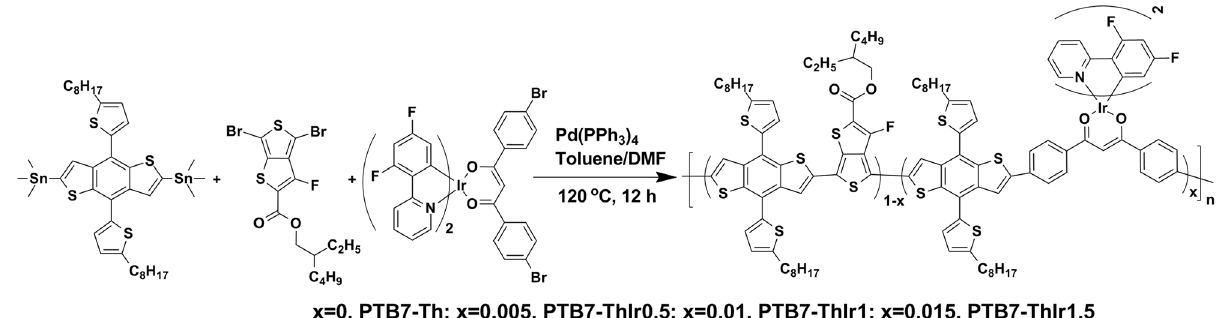
Fig. 1 Synthetic routes of PTB7-Th series polymers with various feed ratio of (dfppy) 2 Ir(dbm) (0 for control polymer PTB7-Th, 0.5, 1 and 1.5 mol% for terpolymers PTB7-ThIrx, weight ( M w ) in the range of 97 to 118 kg mol − 1 (Supplementary Fig. S1, Supplementary Table S1 and Table 1). All polymers exhibited almost identical solubility, similar absorption behavior (Supplementary Fig. S2) and electrochemical properties (Supple-